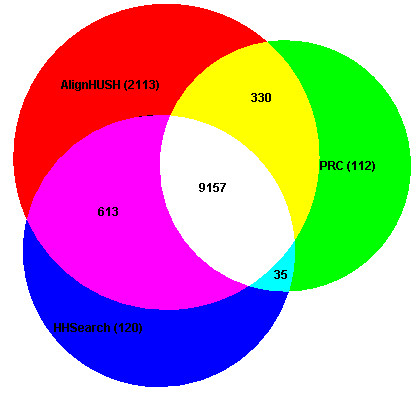
Figure showing the overlap between the related SCOP families found as hits with E-values better than 10 for the three methods studied in this paper. The numbers given along with the name of the method are the true relationships found uniquely using the method. The numbers given in the overlap regions are the relationships found using one or more of the methods. Figure generated using the web-tool from http://www.cs.kent.ac.uk/people/staff/pjr/EulerVennCircles/EulerVennApplet.html.